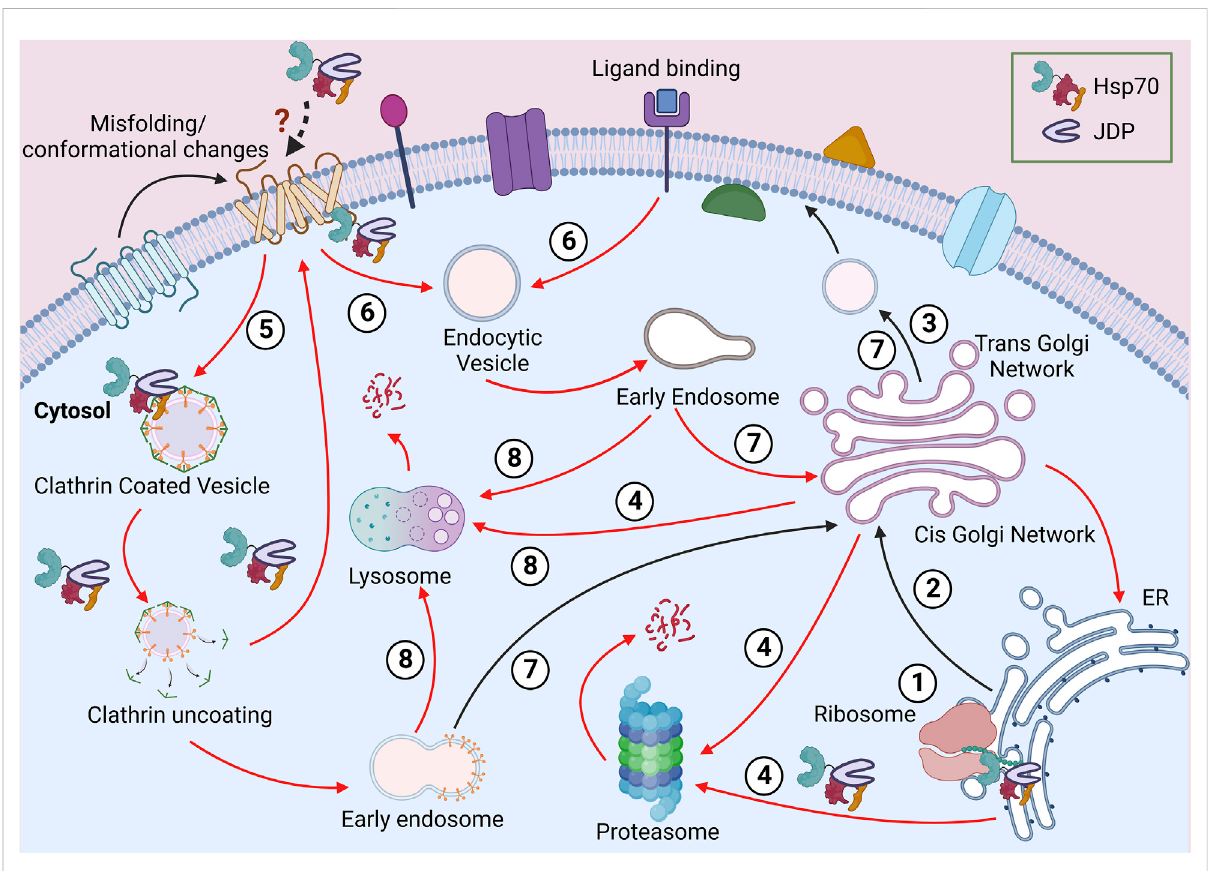
FIGURE 1 Journey of a PM protein. Soon after the ribosomal biosynthesis, the newly synthesized PM protein translocates to the ER (1). The well-folded proteins are packed invesicles and transported to thePM via theGolgiapparatus (2-3).The misfolded proteins from theendomembranesystem can be directed for proteasomal or lysosomal degradation (4). Due to misfolding or stimuli-based conformational change at the PM, proteins can be packaged in clathrin-independent (5) or clathrin-dependent (6) vesicles. These proteins can be recycled to PM (7) or targeted for lysosomal degradation (8). Different steps requiring Hsp70:JDPs are shown in the